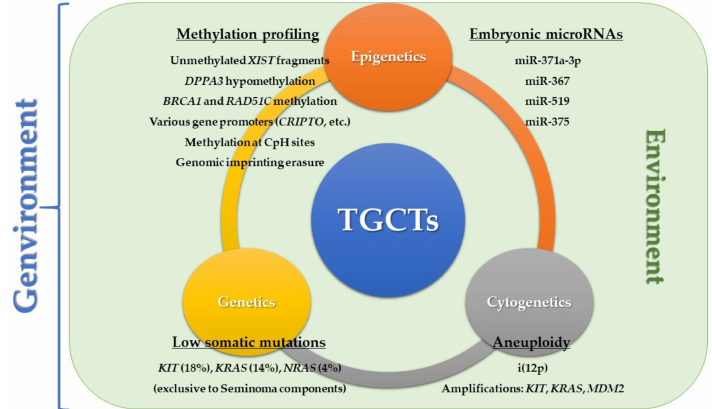
Figure 4. Integrative view of the genvironmental model, with focus on genetic, cytogenetic, and epigenetic factors, which are continuously modified and conditioned by the surrounding environment, ultimately determining the cell fate and tumor progression (see text for